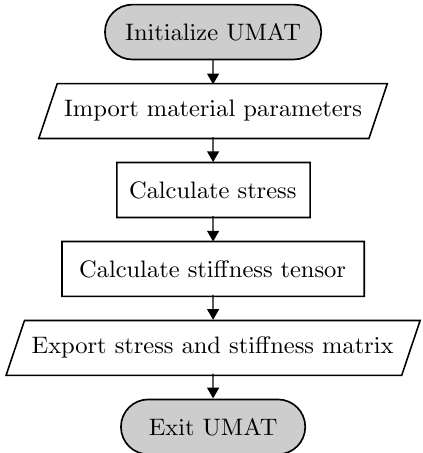
Figure 3. Major sequential substeps in the realized user material